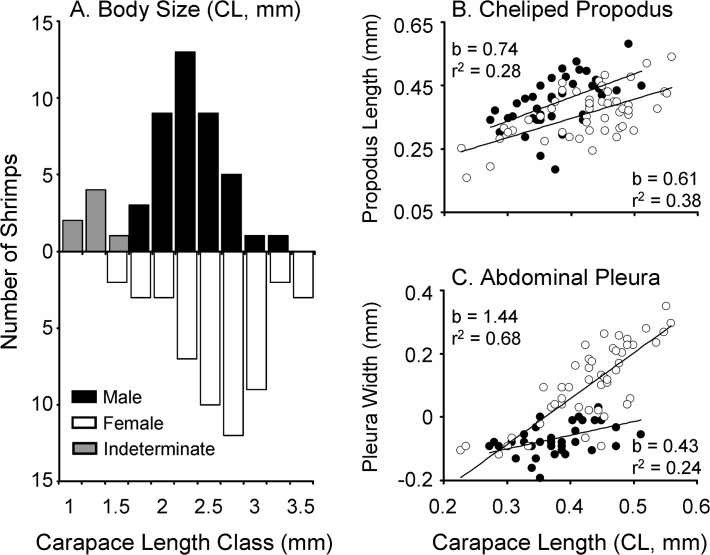
Sexual dimorphism in Odontonia katoi.(A) Size frequency distribution of body size (CL) in males and females. Measurements are in mm. (B) Relative growth of major cheliped propodus length as a function of carapace length in males and females of O. katoi. (C) Relative growth of pleuron of second abdominal segment as a function of carapace length in males and females of O. katoi. Lineal regression equation obtained previous log-log transformation of the data are shown for each sex on Table 1.